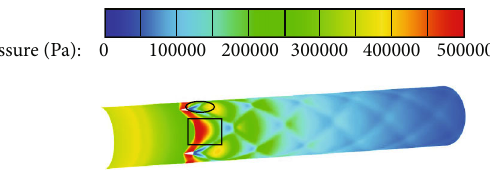
Figure 7: Distribution of the pressure in the chamber.